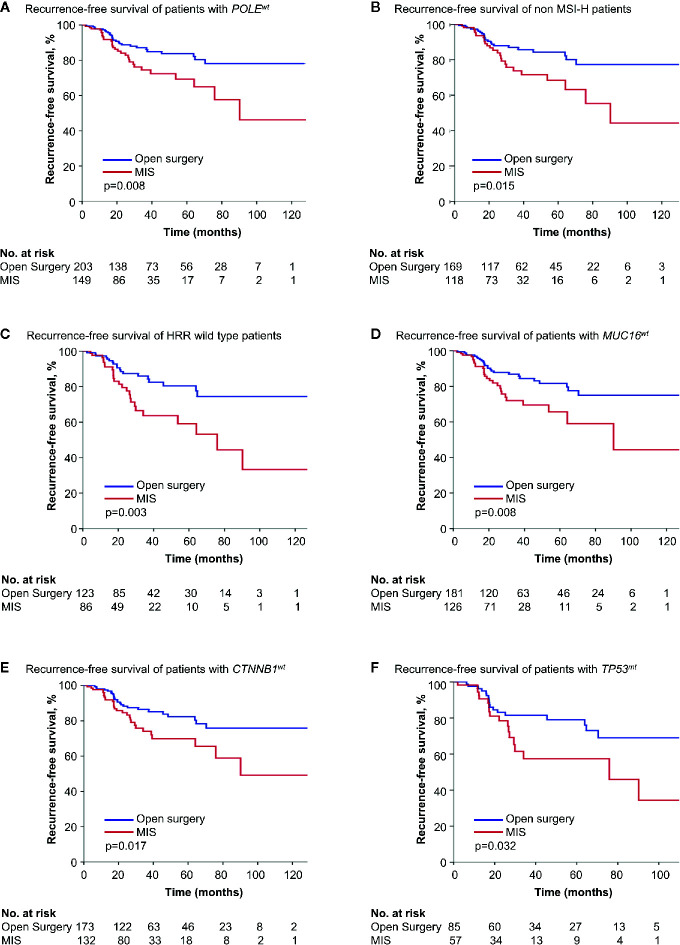
Kaplan-Meier survival curves of patients with different genetic features by surgical approach. (A) Recurrence-free survival of patients with POLEwt. (B) Recurrence-free survival of non MSI-H patients. (C) Recurrence-free survival of HRR with wild type patients. (D) Recurrence-free survival of patients with MUC16wt. (E) Recurrence-free survival of patients with CTNBB1wt. (F) Recurrence-free survival of patients with TP53wt. MIS, minimally invasive surgery; POLEwt, POLE wild type; MSI-H, microsatellite-instability high; HRR, homologous recombination repair; MUC16wt, MUC16 wild type; CTNNB1wt, CTNNB1 wild type; TP53mt, TP53 mutation.